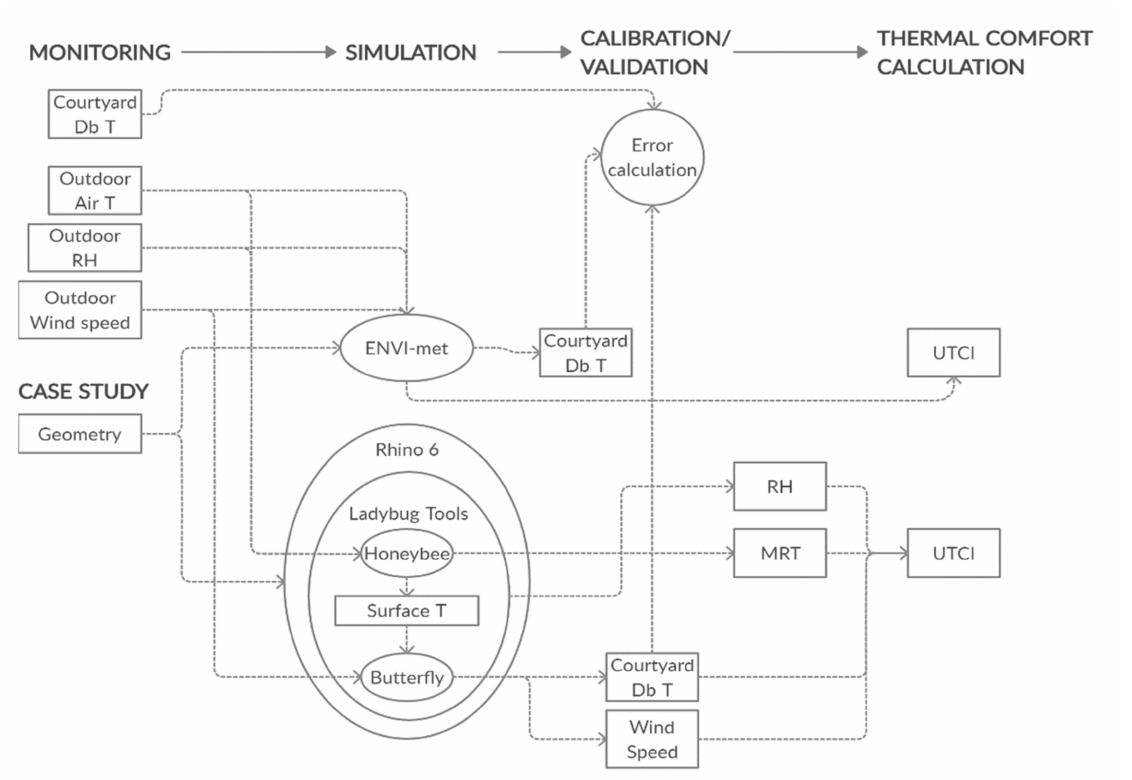
Figure 2. Flowchart showing how different inputs and outputs relate to the simulation tools and validation. Db T = dry bulb temperature. RH = relative